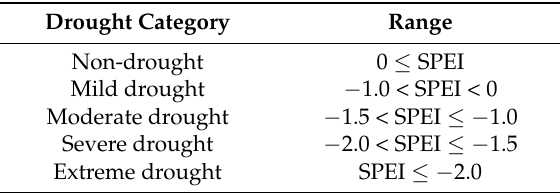
Table 1. Drought classification based on the